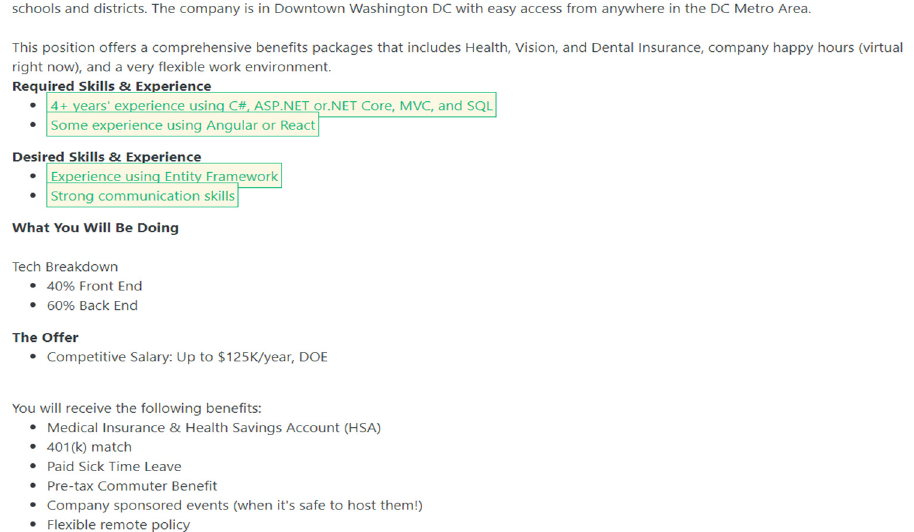
Figure 16. Job advertisement for a .NET developer position with all job requirements found.